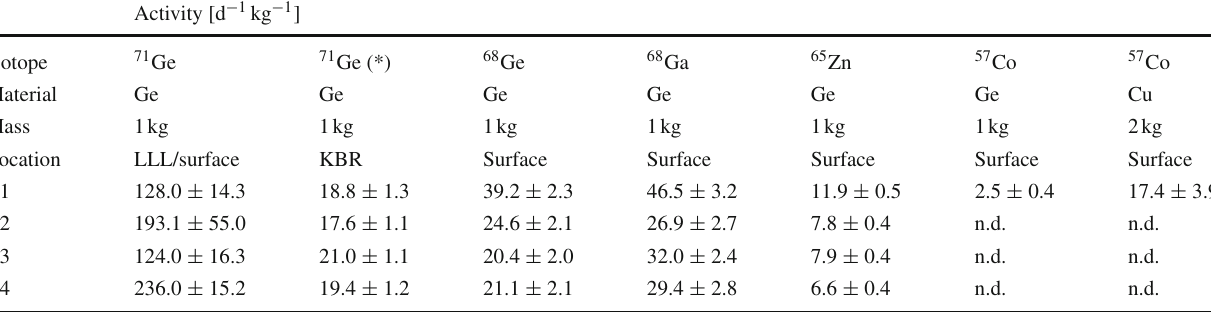
Table 6 Activities in d − 1 kg − 1 of the cosmogenic isotopes at reference time (deployment at KBR: January 24, 2018) derived from the observed time development of the visible background lines in the CONUS data at KBR, the respective decay models, the branching ratios and MC detec- tion efficiencies. In addition, for 71 Ge (marked with (*)), the constant